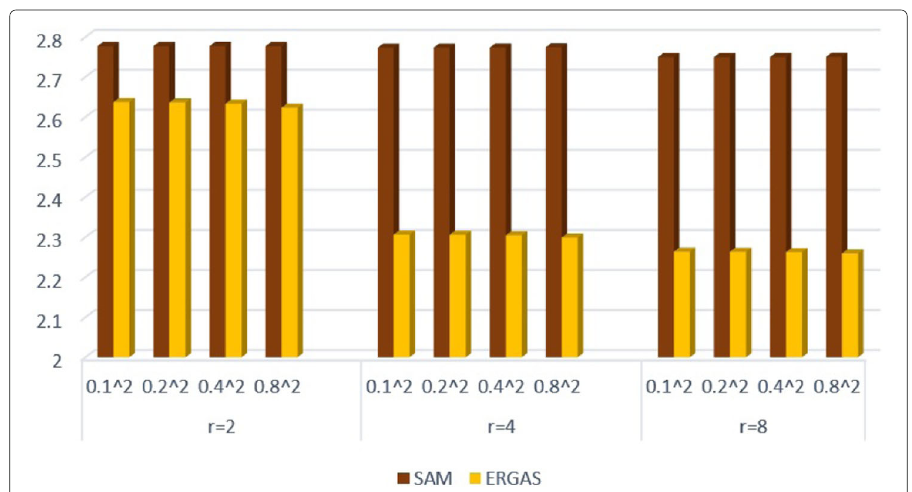
Fig. 5 The influence of the parameters r and ζ on the fusing result concerning SAM and ERGAS indexes. Lower SAM and ERGAS indicate the better-fused